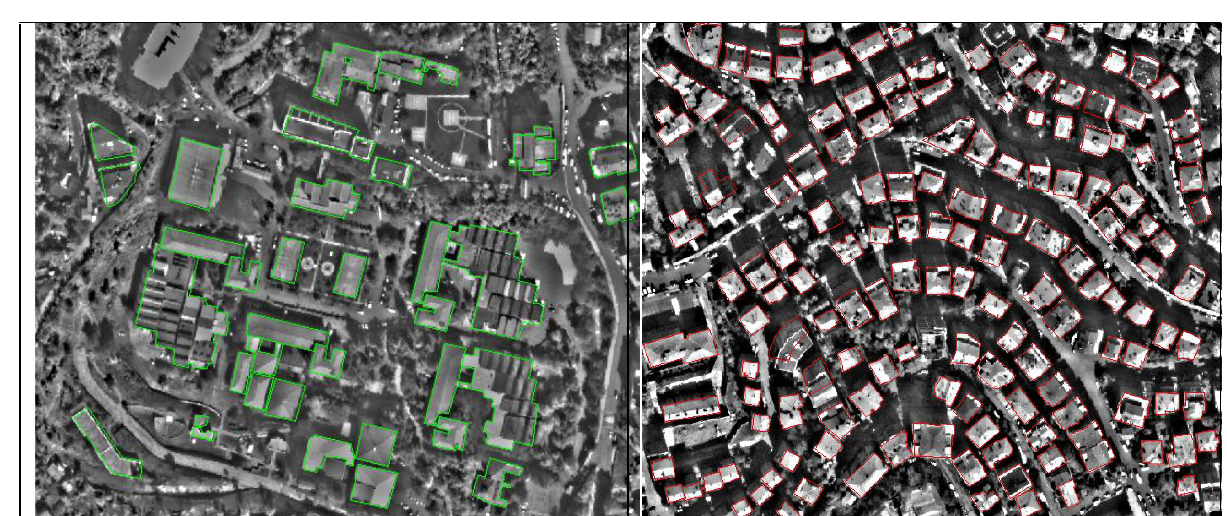
Figure 9. Object extraction from Worldview-1 image in the area of the Zongulak University (left) and a build up area